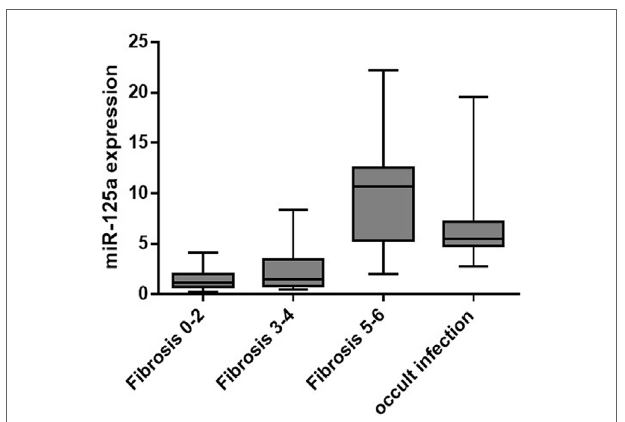
FigUre 1 | miR-125a-5p expression according to liver